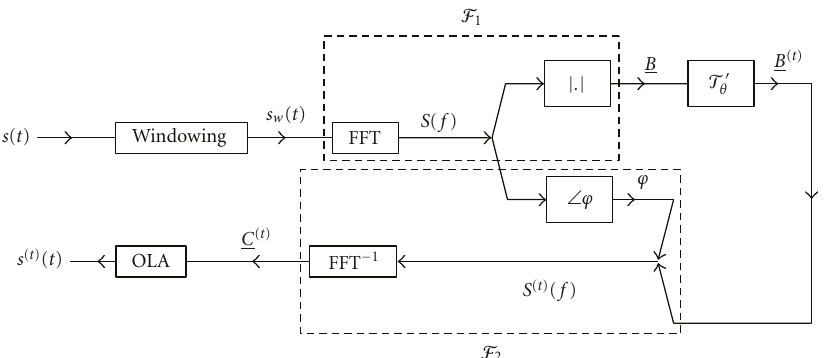
Figure 9: Speech signal feature extraction, transformation, and reconstruction.